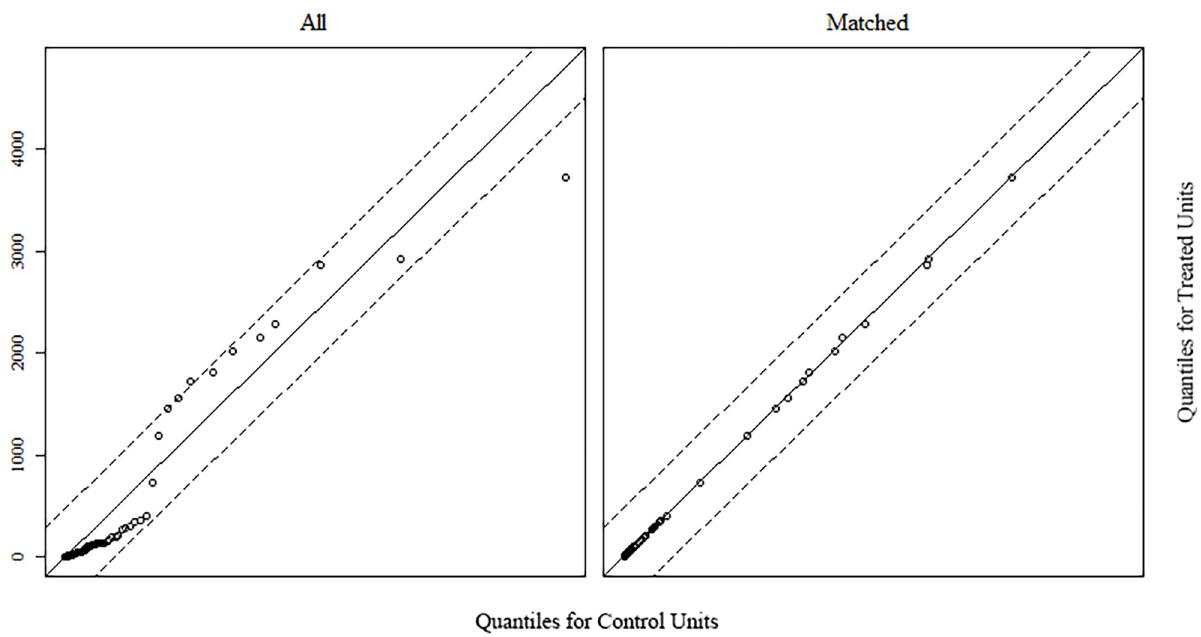
Fig 3. Empirical quantile-quantile plot of the covariate. D epicted are the quantiles of the covariate (ADPPs 2019) for the relaxing and control group before and after matching. Small distances between sample points and the diagonal indicate close similarity.